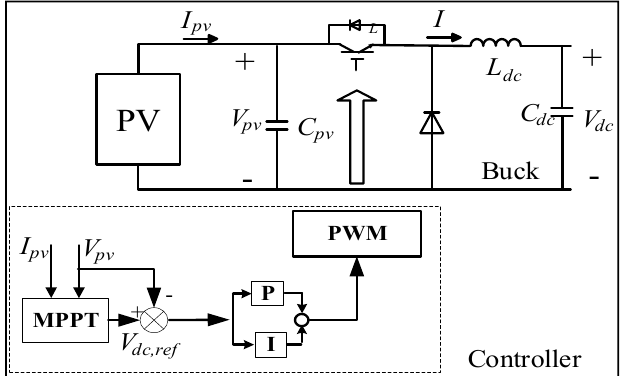
Figure 25. Buck circuit and control system.